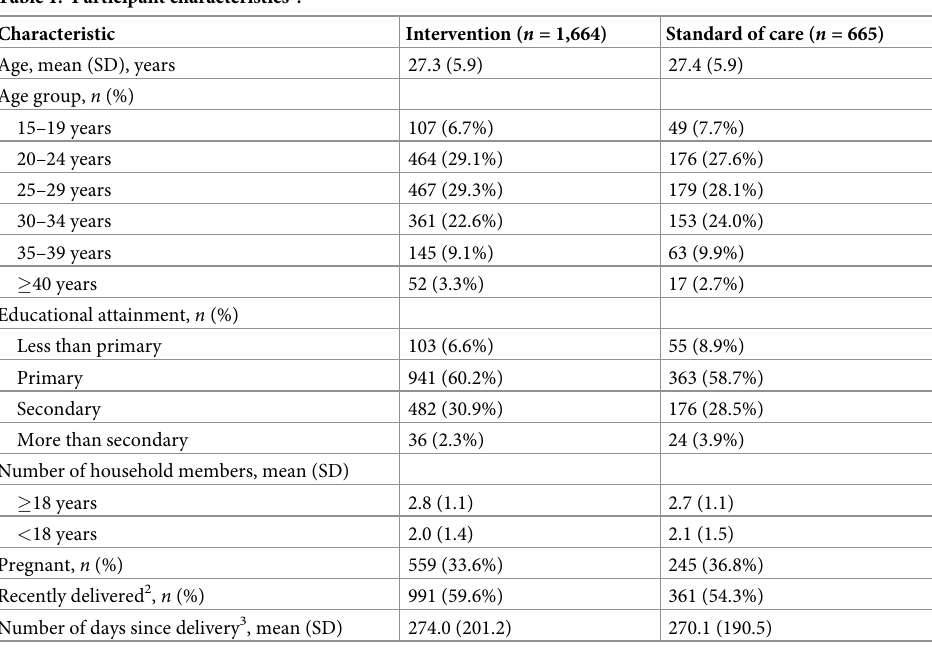
Table 1. Participant characteristics 1